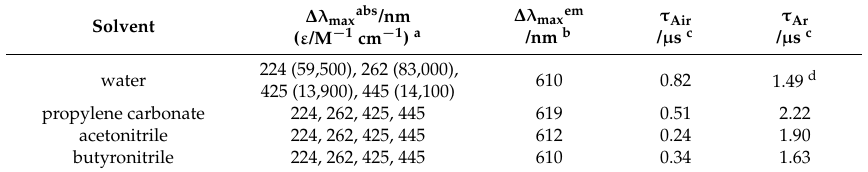
Table 2. Spectroscopic features and emission lifetimes of [Ru(phen) 2 (4-Clp)] 2+ in solution at 25.0 ◦ C.